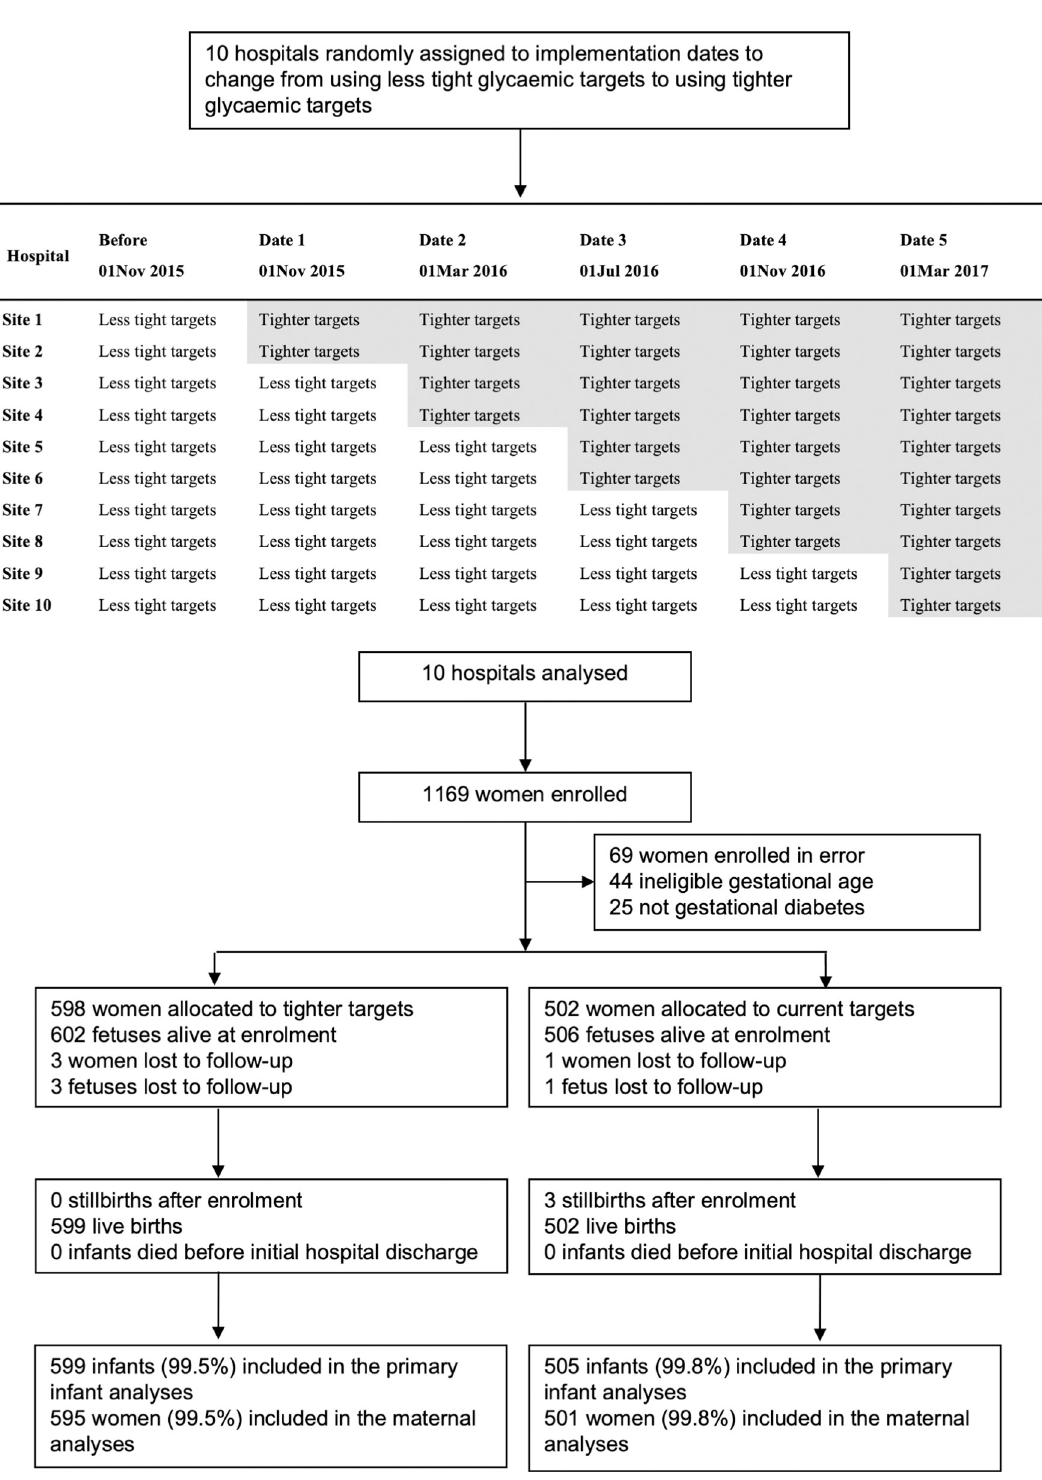
Fig 1. Trial profile. The shaded area indicates the change of a site to the tighter targets and the time of that change.